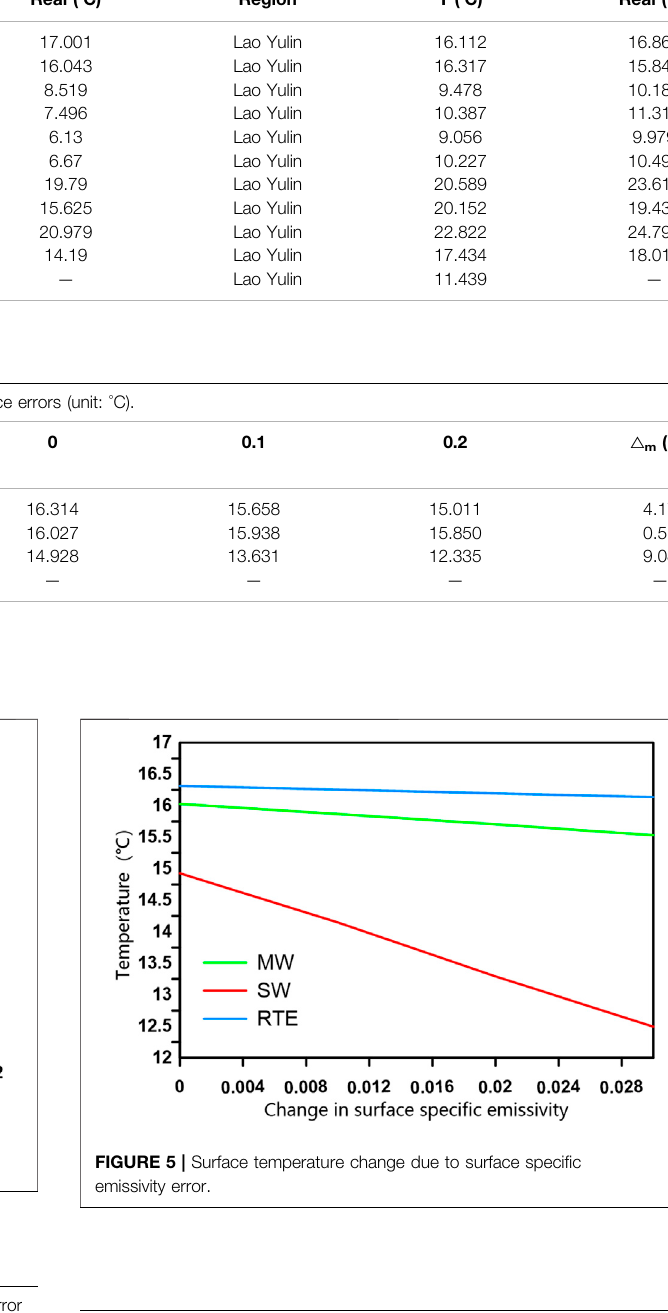
TABLE 7 | Changes in surface temperature due to near-surface temperature errors (unit: ° C).